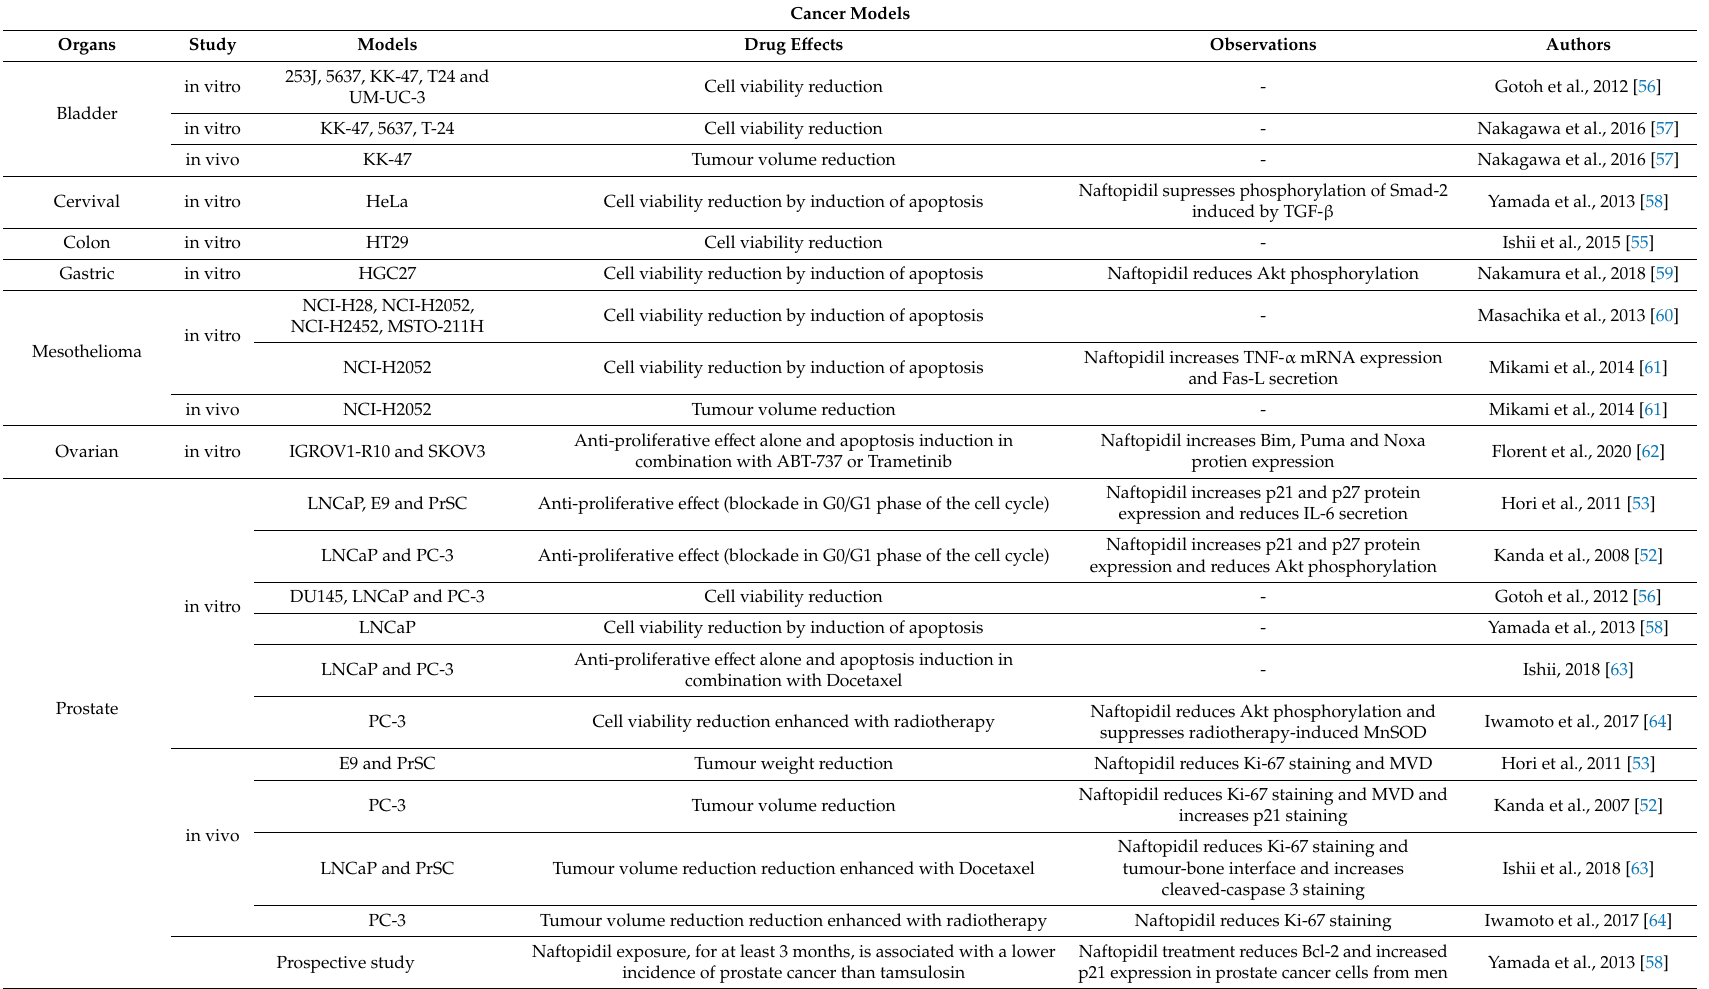
Table 1. Anti-cancerous properties of